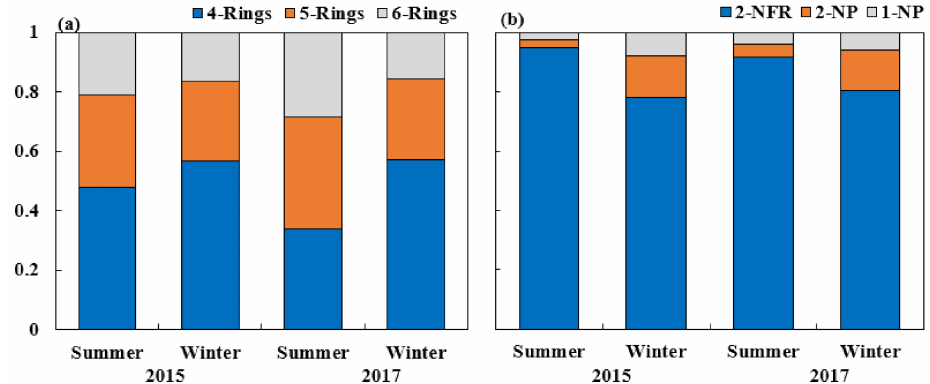
Figure 2. The ratio of each component to the total PAHs ( a ) and NPAHs ( b ) in PM 2.5 during sampling